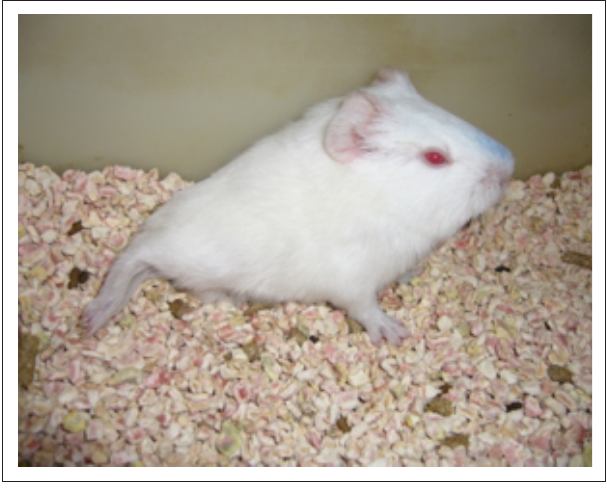
Source : Photographed by R.A. Schultz FIGURE 7: Guinea pig 48 h after dosing with diplonine, showing no clinical signs apart from righting reflexes